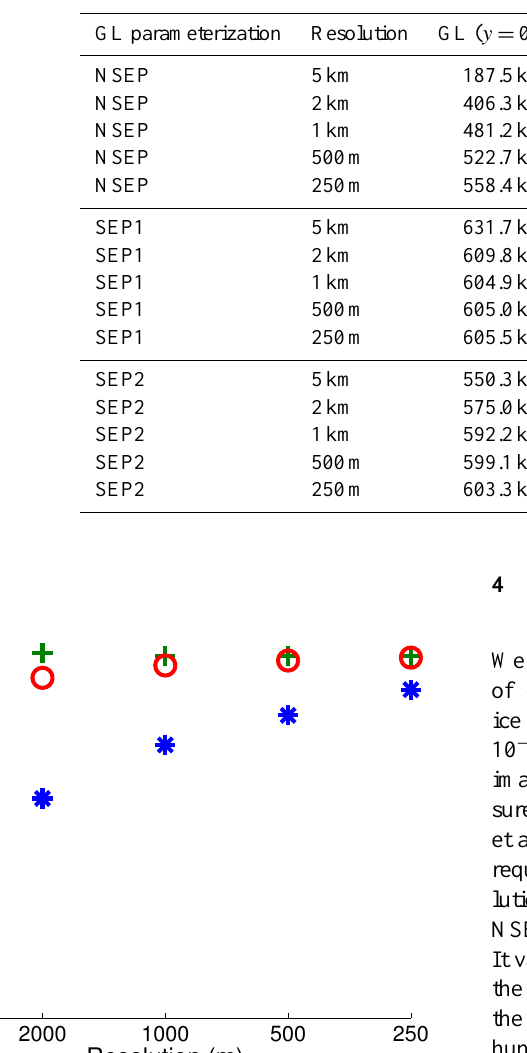
Table 1. Initial grounding line position and span for the NSEP, SEP1 and SEP2 simulations.